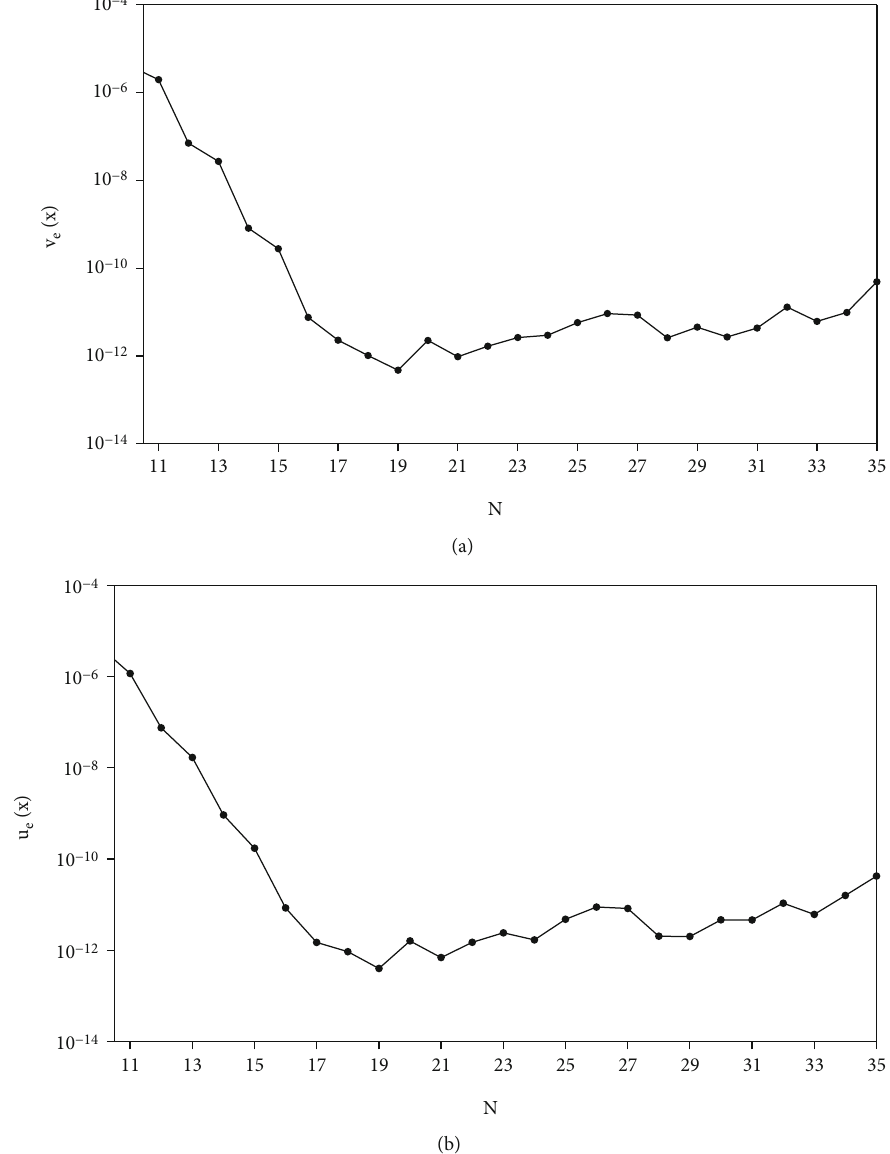
Figure 6: Maximum absolute errors of (a) u ð x Þ and (b) v ð x Þ at di ff erent values of N for Example